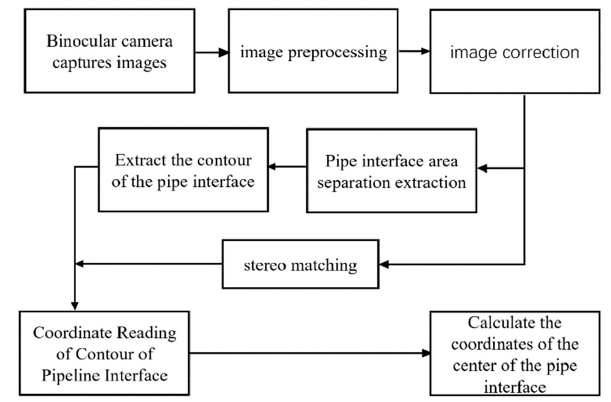
Figure 5. Flow chart of obtaining target coordinate